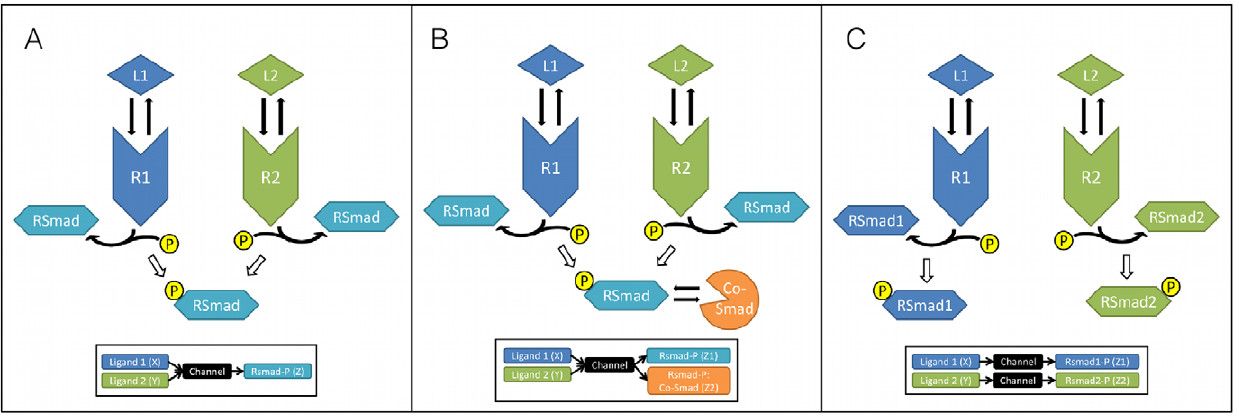
Figure 1. Smad signaling pathway network models. ( Model A ) A single channel of one RSmad with a single output. ( Model B ) A single channel with two outputs, the phosphorylated RSmad and the RSmad:Co-Smad heterodimer. ( Model C ) The dual channel with two distinct RSmads and two outputs. The insets diagram the information transmission topology of signal (ligand), channel, and output (complexes). Note that this diagram represents a phosphorylation reaction by the receptors, not a phosphotransfer.